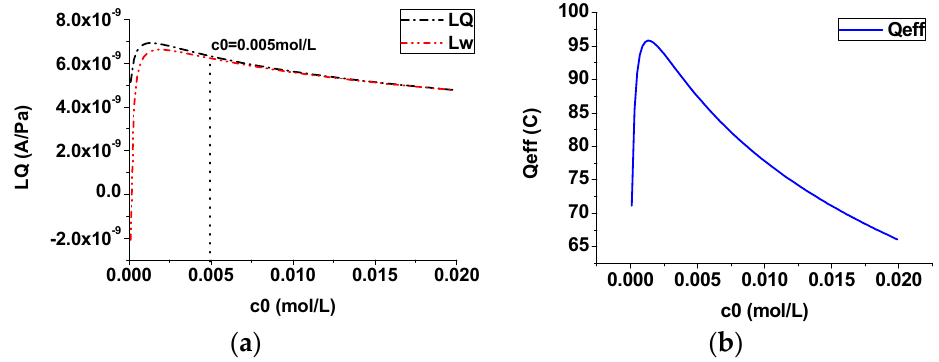
Figure 12. Effect of the salinity (time-harmonic condition, including the large-Debye-length case): ( a ) streaming current coupling coefficient; ( b ) effective net residual charge density.